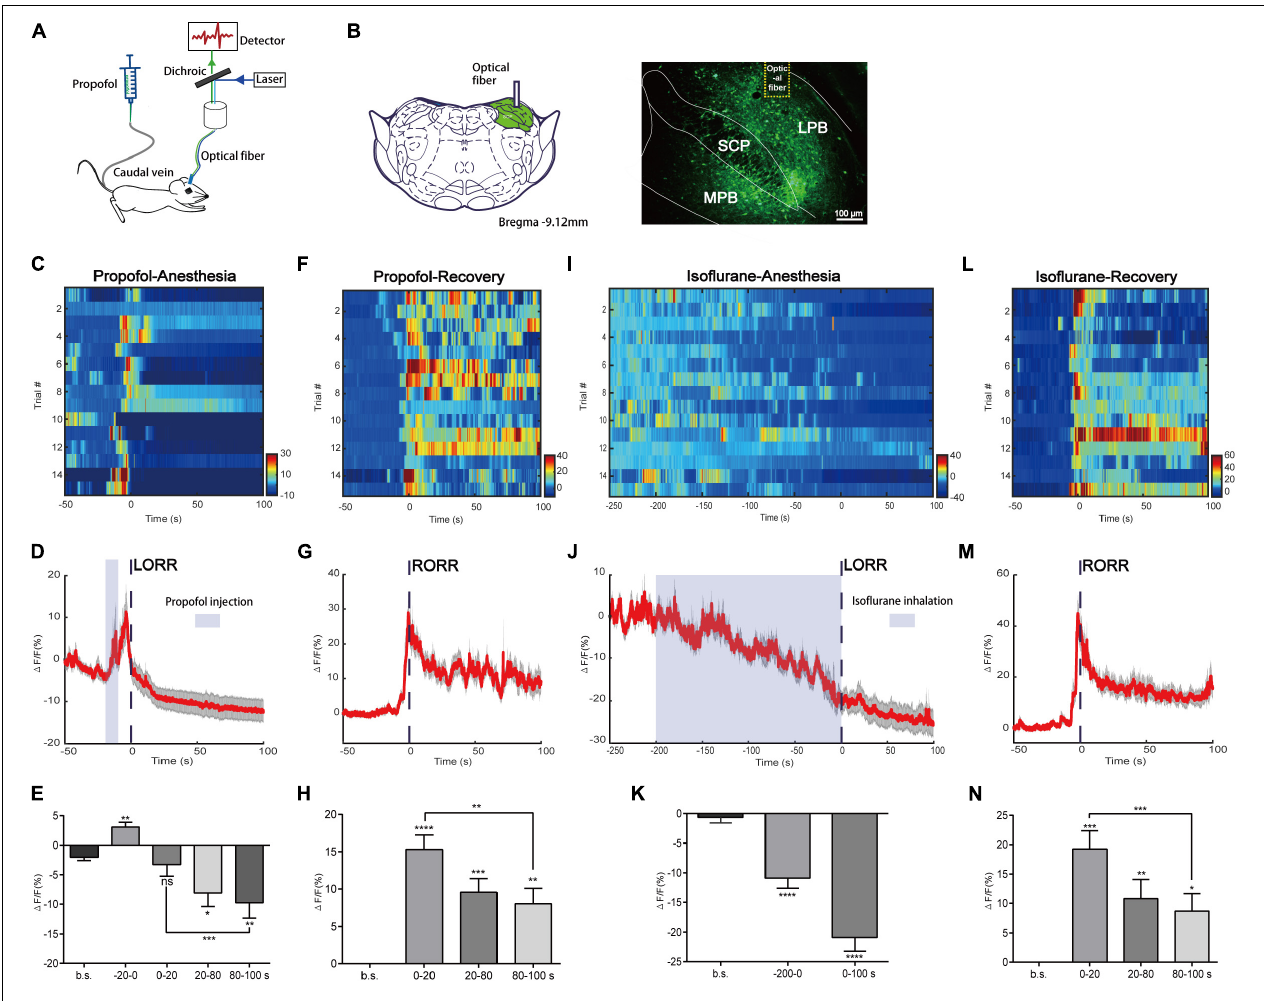
FIGURE 1 | Neural dynamics of parabrachial nucleus (PBN) in response to propofol and isoflurane. (A) Scheme of fiber photometry setup. (B) Expression of GCaMPs in PBN neurons. Dashed yellow lines indicate the position of optical inserts. (Scale bars: 100 µ m.) (C–E) Ca 2 + signals associated with propofol-induced loss of righting reflex (LORR). Heatmap illustration of Ca 2 + signals aligned to the initiation of LORR trails. Each row plots one trail and a total of 15 trials are illustrated. Color scale at the right indicates (cid:49) F/F (C) . Peri-event plot of the average Ca 2 + transients. Thick lines indicate the mean and shaded areas indicate SEM (D) . Statistical chart of changes in Ca 2 + signals in propofol-induced unconsciousness (E) . (cid:49) F/F represents change in GCaMPs fluorescence from the mean level before the propofol is given. b.s. represents baseline, which is the averaged (cid:49) F/F between t = –50 and –20 s. (–20 to 0 s) represents the averaged (cid:49) F/F from propofol injection to LORR. 0 represents the moment of LORR. (0–20 s), (20–80 s), and (80–100 s) represent the averaged (cid:49) F/F in anesthesia period between t = (0–20 s), t = (20–80 s), and t = (80–100 s), respectively. (F–H) Ca 2 + signals associated with emergence from propofol anesthesia. 0 represents the moment of RORR. b.s. represents baseline, which is the averaged (cid:49) F/F between t = –50 and 0 s. The PBN neurons were activated during emergence from propofol anesthesia. Ca 2 + signals associated with LORR (I–K) and emergence (L–N) from isoflurane anesthesia ( n = 5). Same conventions as in the propofol group. PBN neurons were inhibited in the process of isoflurane anesthesia and activated in the emergence period. All data are shown as mean ± SEM. The p -values, compared with baselines or (0–20 s), are calculated by using paired t -test. ∗ p ≤ 0.05; ∗∗ p ≤ 0.01; ∗∗∗ p ≤ 0.001; ∗∗∗∗ p ≤ 0.0001; ns, not significant. LPB, lateral parabrachial nucleus; SCP, superior cerebellar peduncle; MPB, medial parabrachial